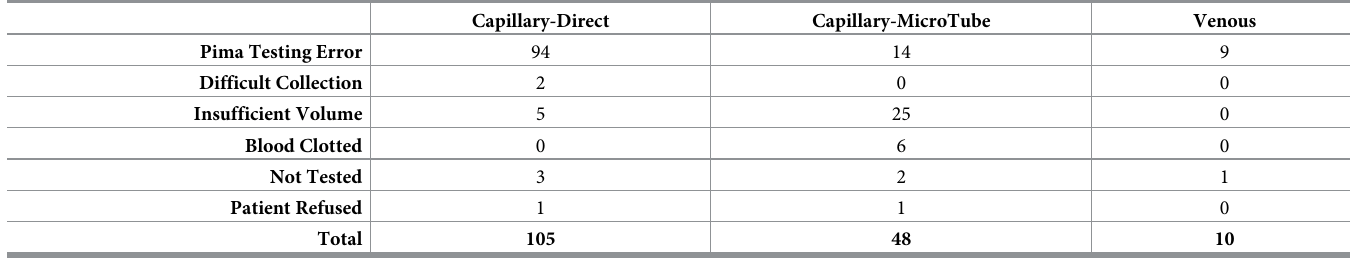
Table 5. Reason for CD4 results recording failure by specimen